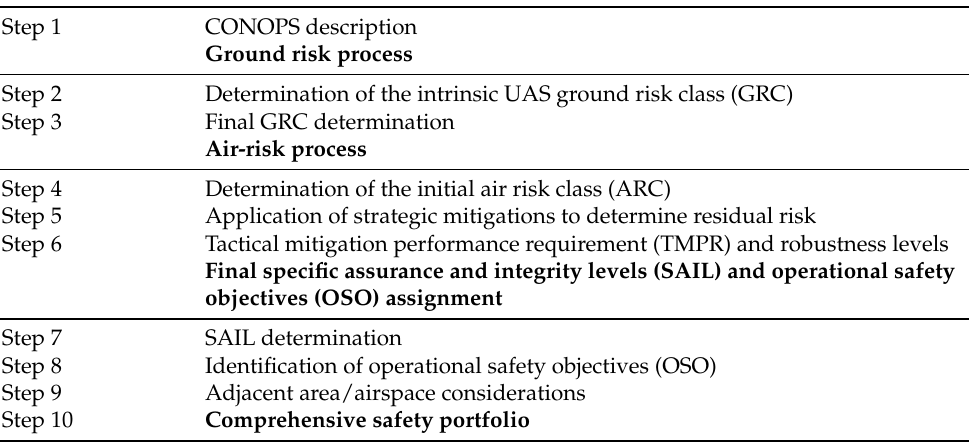
Figure 2. Graphical representation of the SORA semantic model. Reprinted with permission from [20]. Copyright (2019) JARUS. Table 1. Subprocesses and steps in the SORA process, compiled from